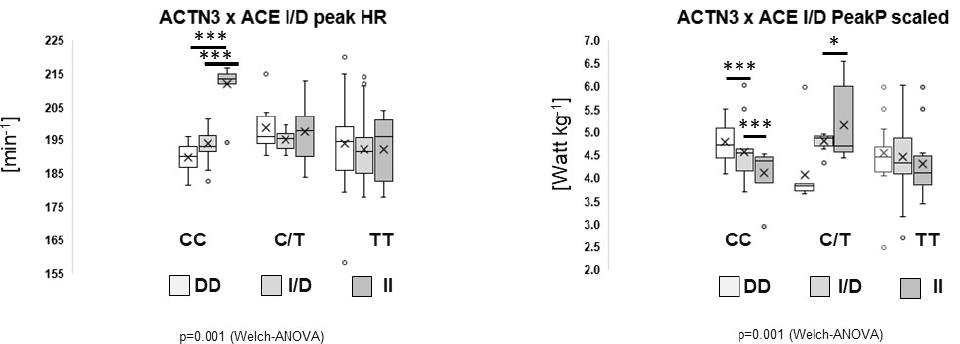
Figure 5. Main genotype interactions with cardiorespiratory parameters. Box-whisker plots of the association of peak heart rate and scaled peak power during CPX-testing with the interaction between the ACTN3 (rs1815739) and ACE-I/D (rs1799752) genotypes. ANOVA with post hoc test of least significant difference. Note: Post-hoc effects were identified between noncarriers and carriers of the I-allele (ACE) in CC genotypes of ACTN3 (rs1815739) for the maximal heart rate during the ramp test to exhaustion. Conversely, the scaled peak power output was lowest in the homogenous carriers of the I-allele (ACE) in CC genotypes. * and *** indicate, p ≤ 0.05 and 0.001, respectively, for the indicated comparisons.